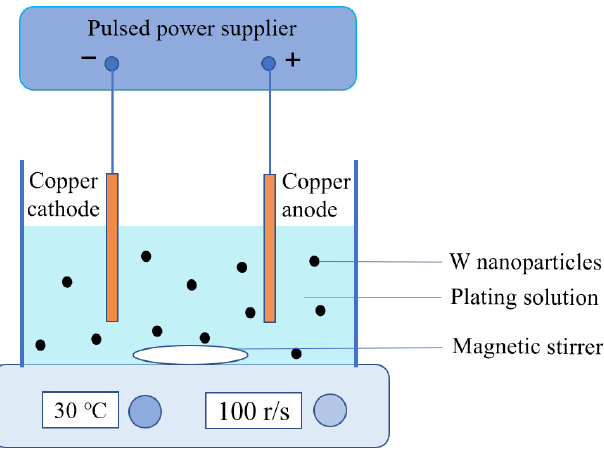
Figure 2. The schematic illustration of the pulse plating device. The composition of the plating solution was CuSO 4 · 5H 2 O (125 g/L), H 2 SO 4 (200 g/L), NaCl (60 mg/L), polyethylene glycol (PEG, 0.2 g/L), and sodium dodecyl sulfate